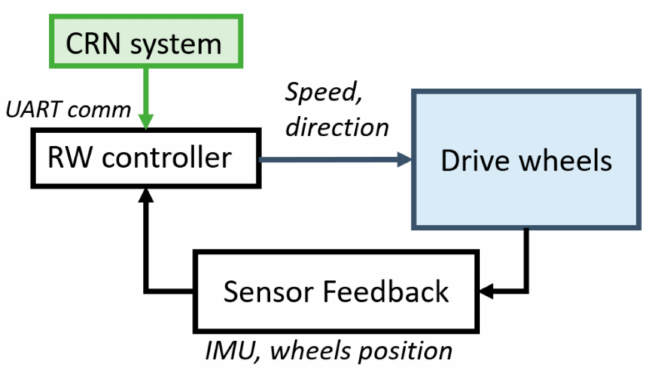
Figure 3. Electronics architecture of CRN and MEBot